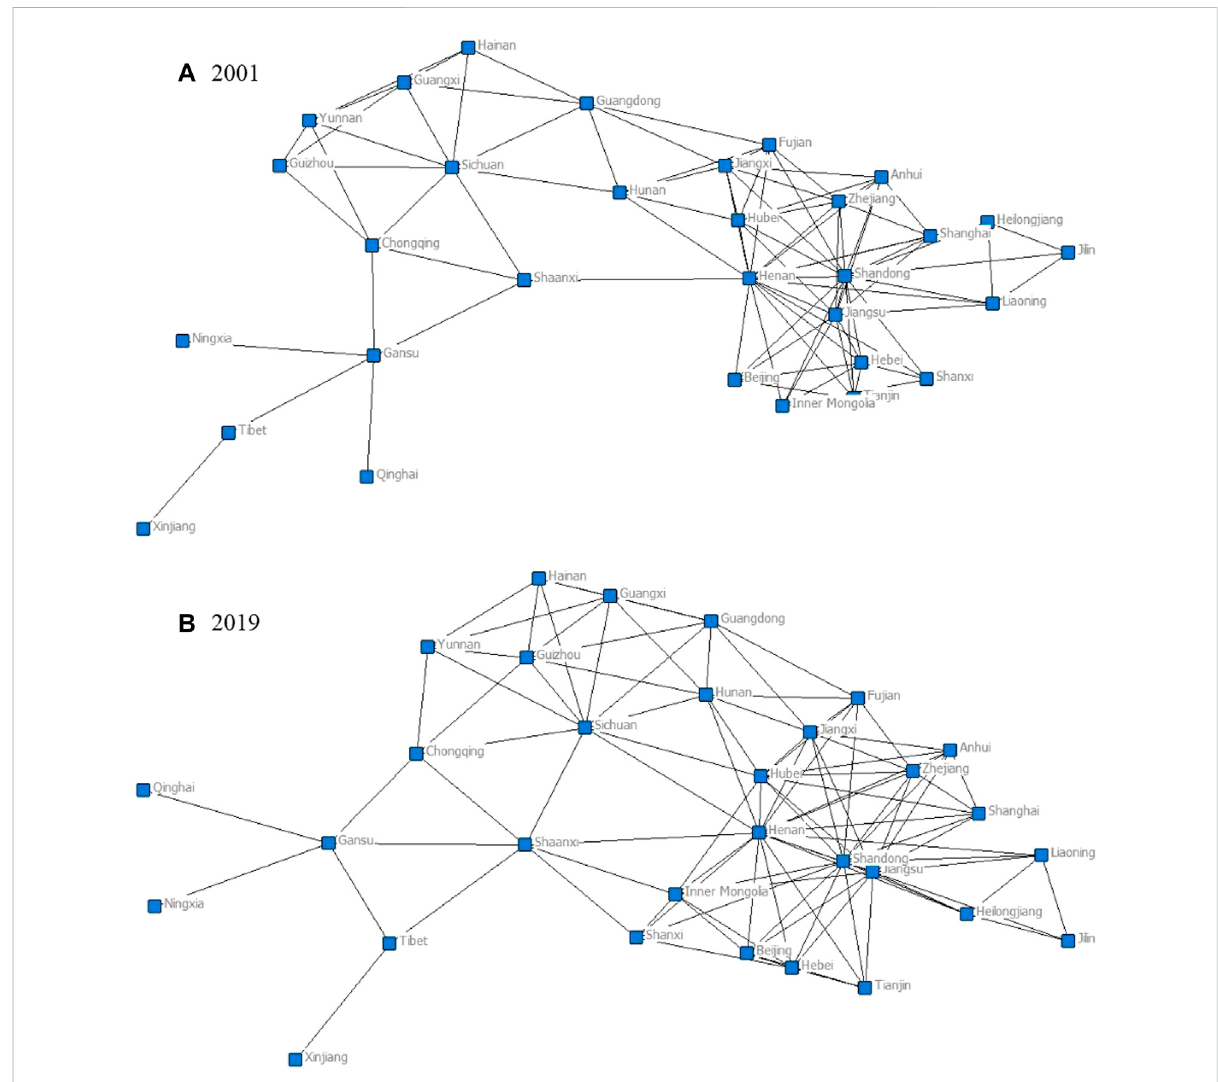
FIGURE 3 Social network structure based on centrality in China.